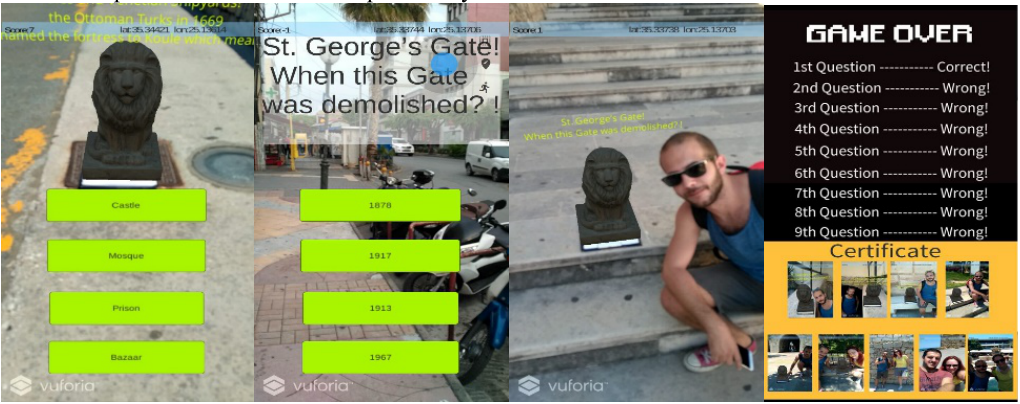
Figure 3. Quiz with or without AR & Player